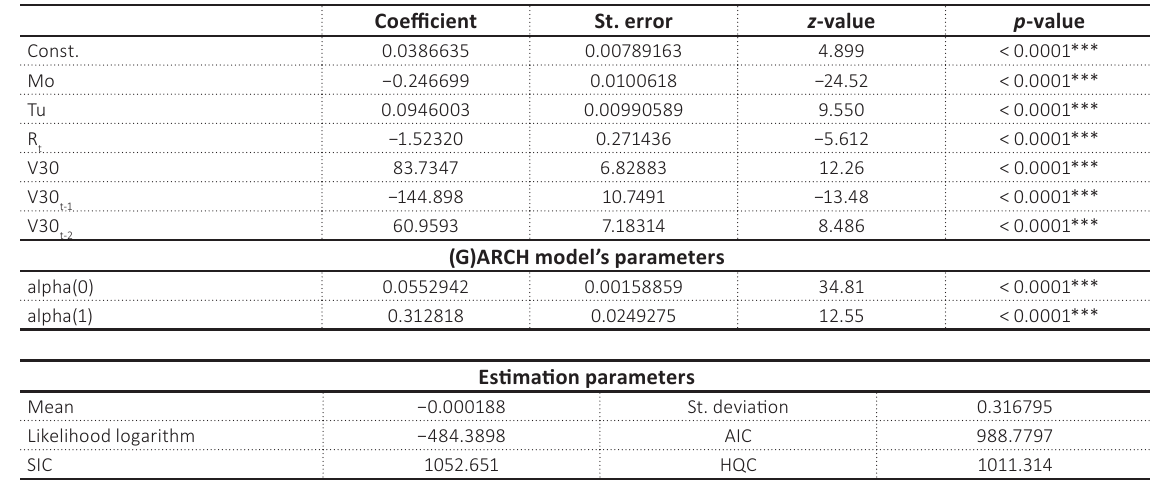
Source: Own calculations.